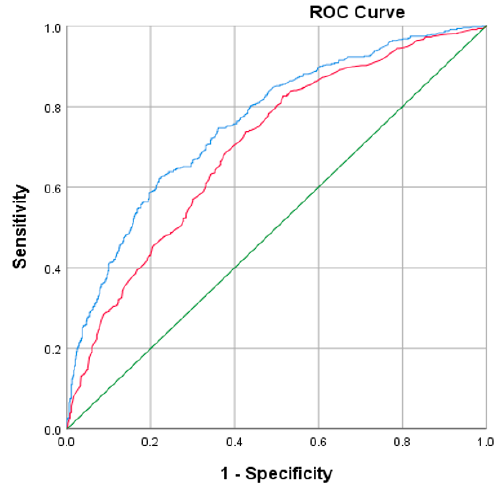
Figure 1. Receiving operator characteristic (ROC) curves to compare the multivariable models ROC curves are represented, using only demographic variables (Model 1 in red), and assessing the additional contribution from the inclusion of food literacy behaviours (Model 2 in blue).